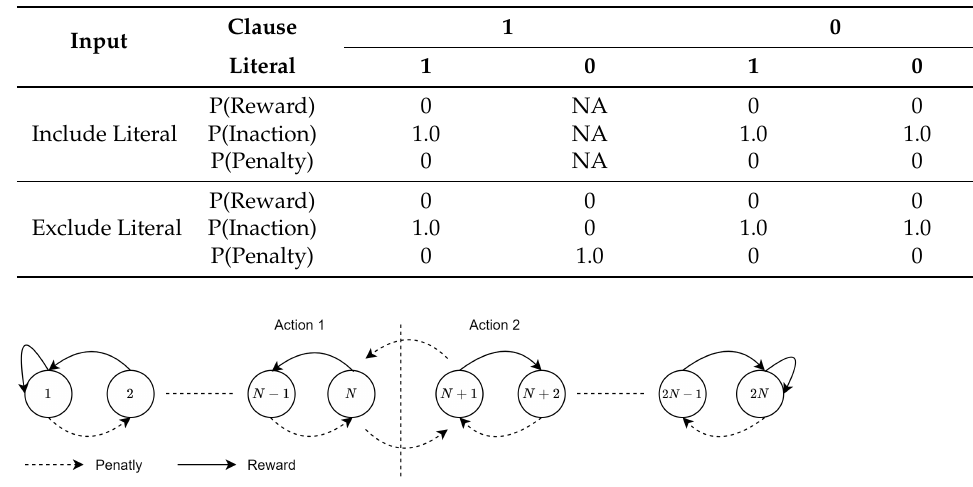
Table 2. The Type II Feedback [16].